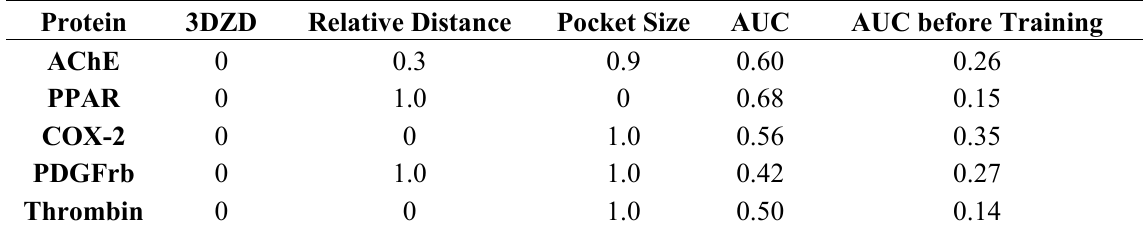
Table 4. Target-specific training results for the five difficult